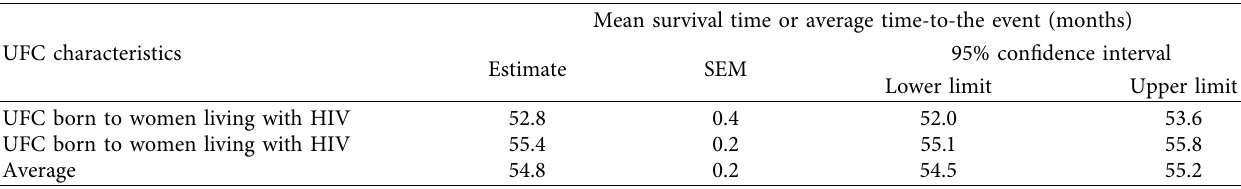
Table 4: Average time-to-event ∗ for under-five-year-old children born to women living with and not living with HIV between January 2014 and December 2018 in Botswana ( n � 12,798). UFC characteristics